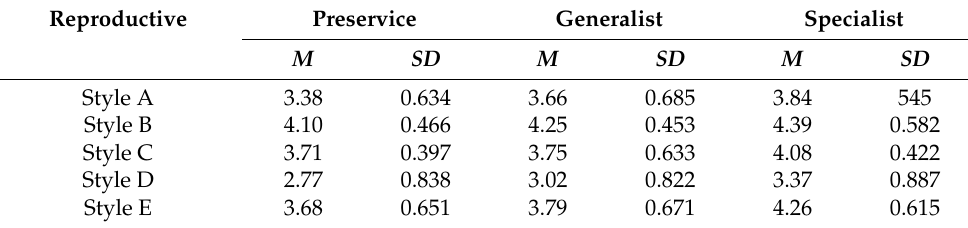
Table 3. Descriptive statistics for reproductive cluster (preservice, generalist, and specialist teachers).